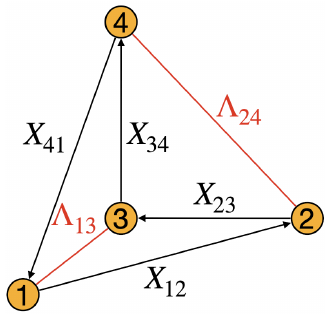
Figure 6 . Tetrahedron in the dual quiver corresponding to a vertex, with fields